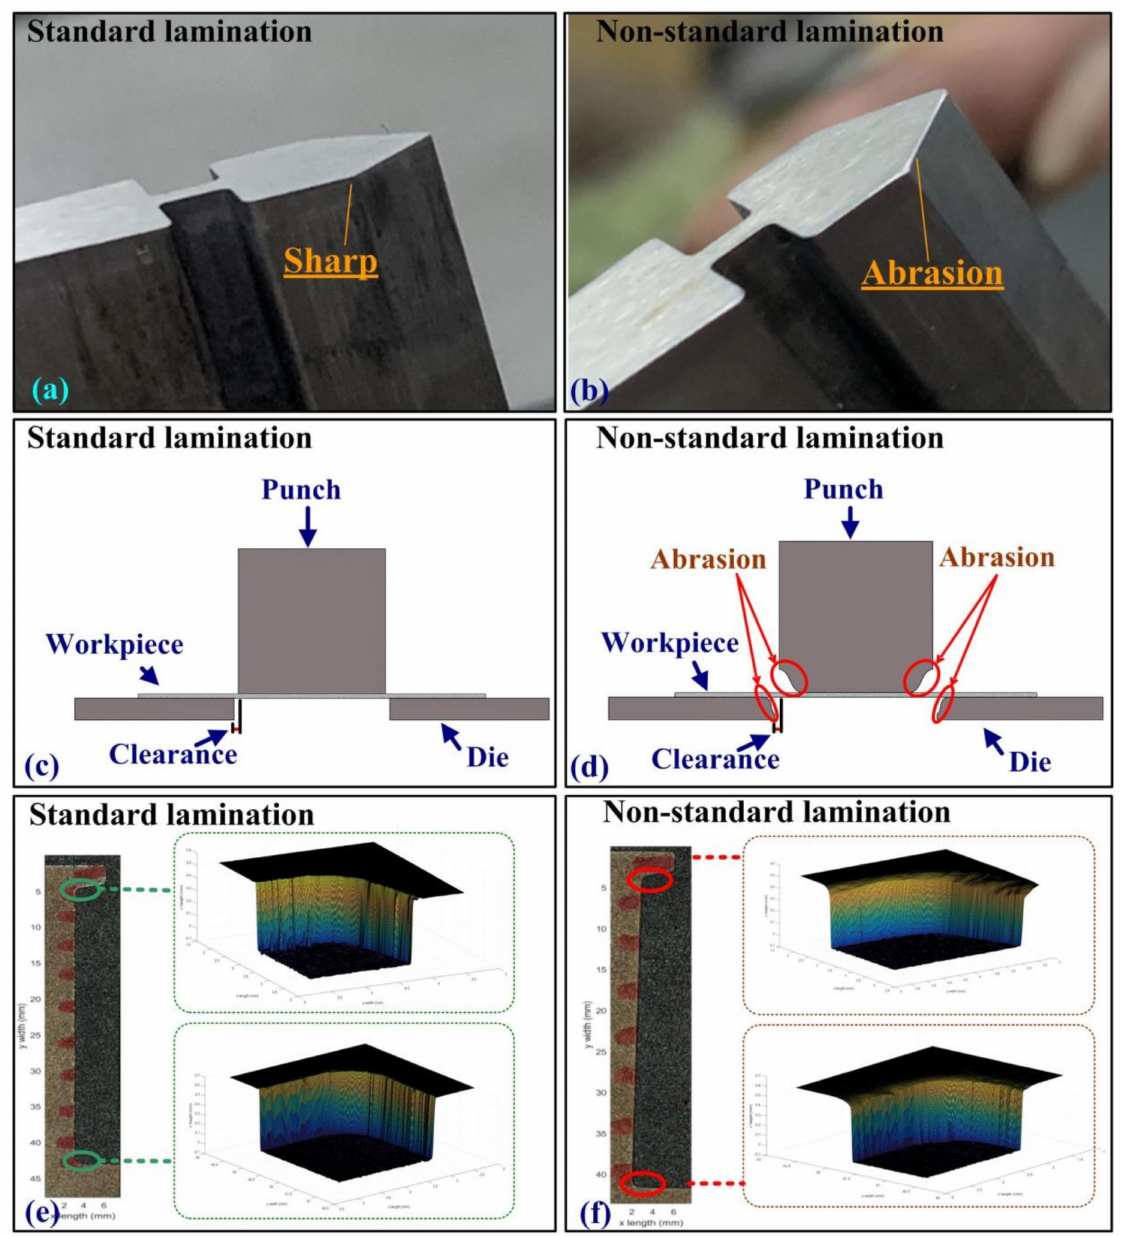
Figure 3. Punch in ( a ) optimal condition showing sharp edges and ( b ) sub-optimal condition showing blunt edges. Schematic illustration showing fabrication of steel workpieces using cutting edges in ( c ) optimal condition and ( d ) sub-optimal condition. Surface profile of steel workpiece fabricated using cutting tools in ( e ) optimal condition and ( f ) sub-optimal